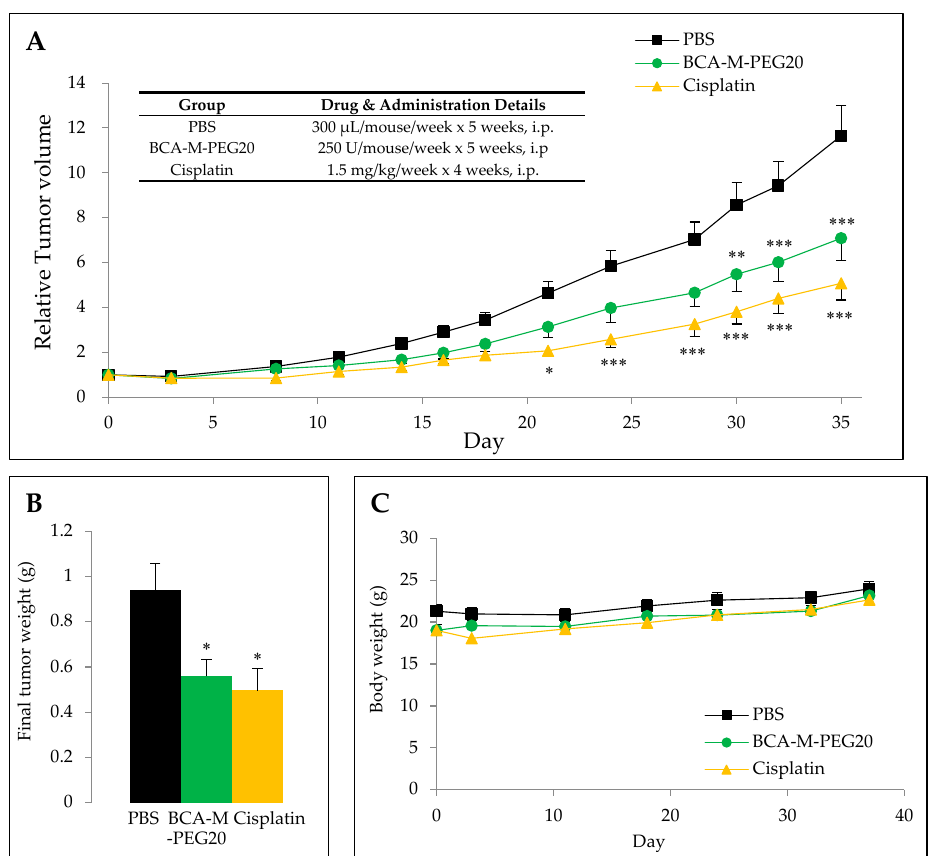
Figure 7. In vivo antitumor activities of BCA-M-PEG20. ( A , B ) Tumor growths (relative tumor volume and final tumor weight) were significantly suppressed by BCA-M-PEG20 and cisplatin ( n = 10). ( C ) Mice body weights were measured regularly. Results are presented as means ± SEM. For relative tumor volume, multiple comparisons were performed using two-ways ANOVA with Bonferroni’s post-tests. For final tumor weight, data were analyzed using Mann-Whitney U-test. * p < 0.05, ** p < 0.01 and *** p < 0.001. All analyses were performed using the Prism software (GraphPad Software Inc.).